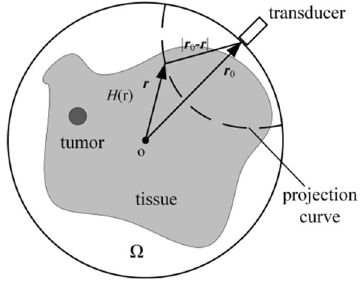
Figure 1. Circular scan projection